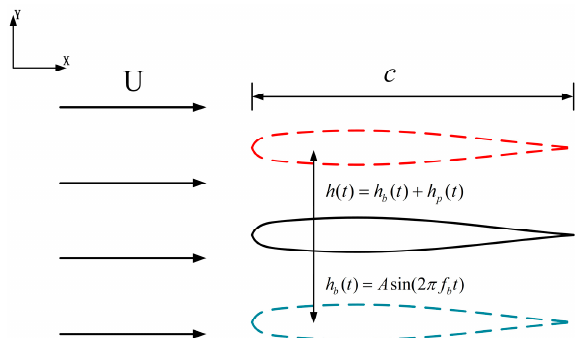
Figure 1. Schematic diagram of the flow field.